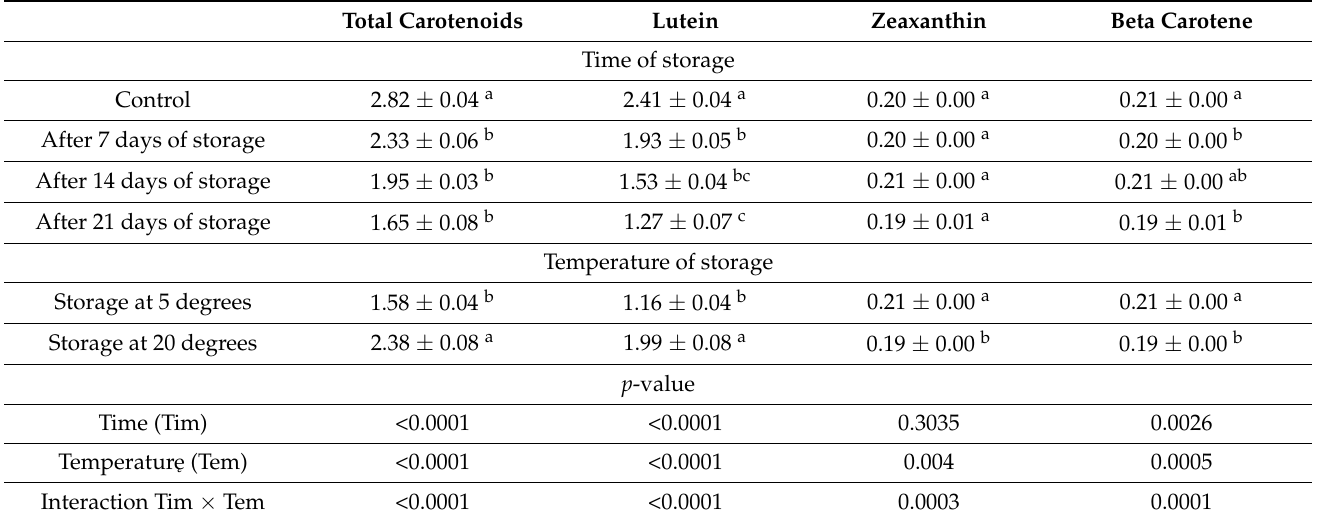
Table 2. The content of total carotenoids and individually identified carotenes in apple (in mg/100 g FW). Total Carotenoids Lutein